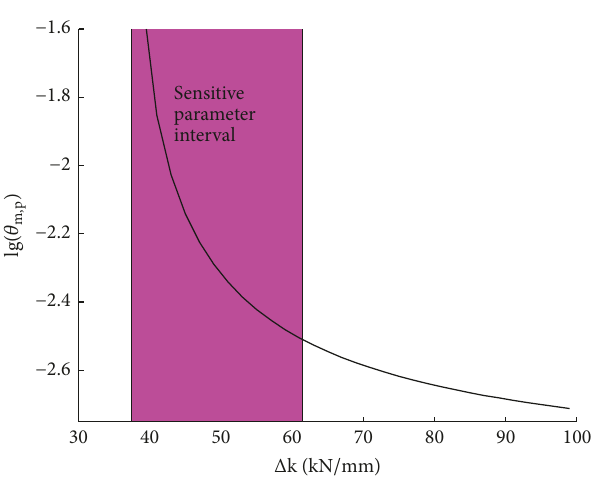
Figure 15: Influence of Δ k on resonant peak.